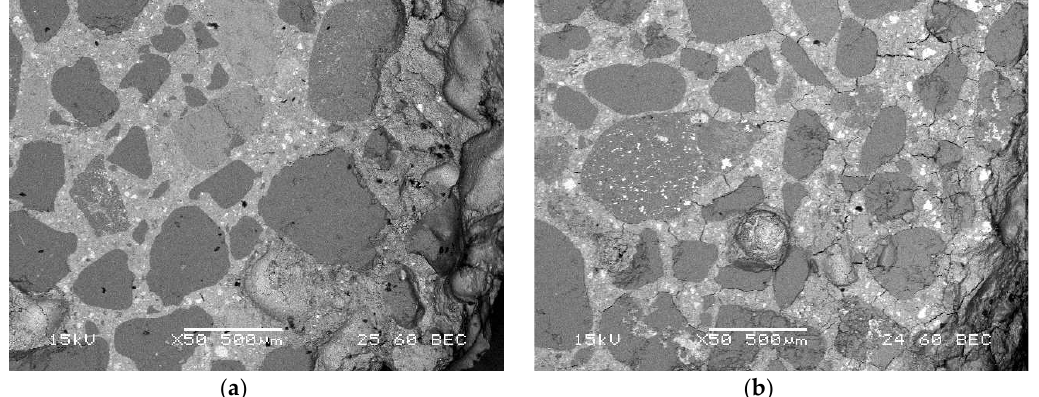
Figure 11. Microscopic images of polymer-cement mortar, p/c = 0.20, stored in 5% MgSO 4 solution: ( a ) after 12 months; ( b ) after 42 months.